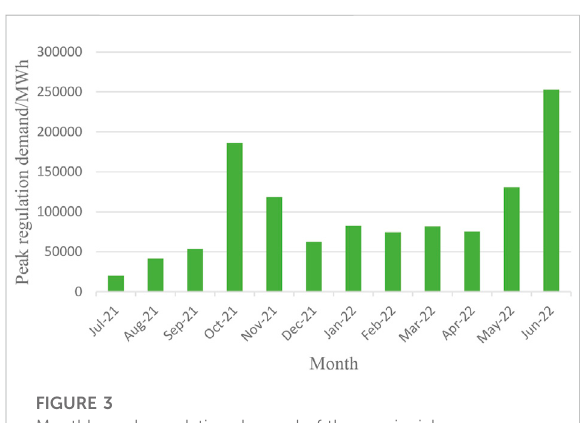
FIGURE 3 Monthly peak regulation demand of the provincial power system from July 2021 to June 2022.